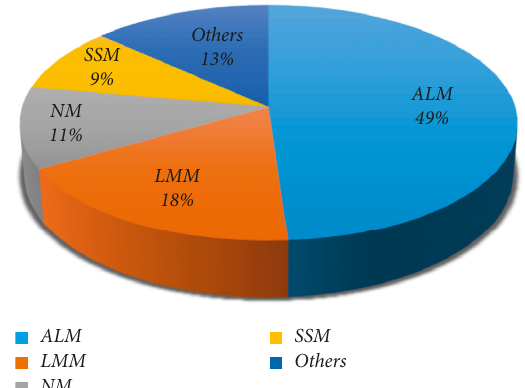
Figure 2: Distribution of cutaneous melanoma according to his- topathological